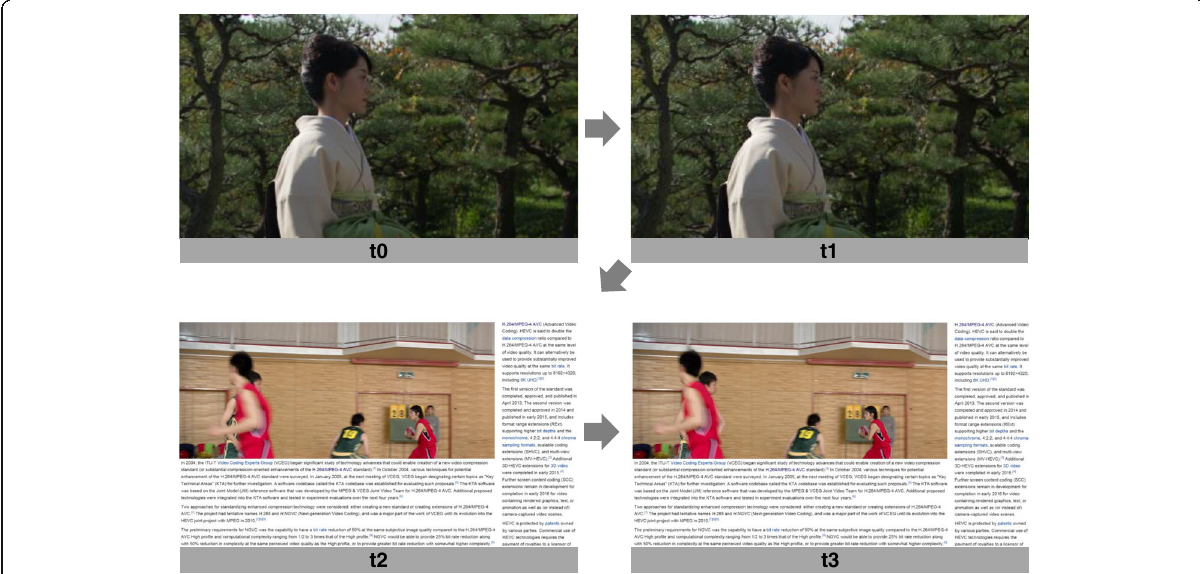
Fig. 14 Image sequences to test image quality consistency (Kimono 1920 × 1080, BasketballDrive + Text 1920 × 1080). t2 shown in Fig.